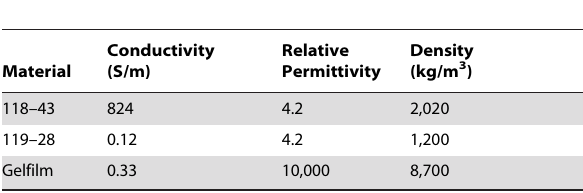
Table 2. Electrical properties and mass density of the